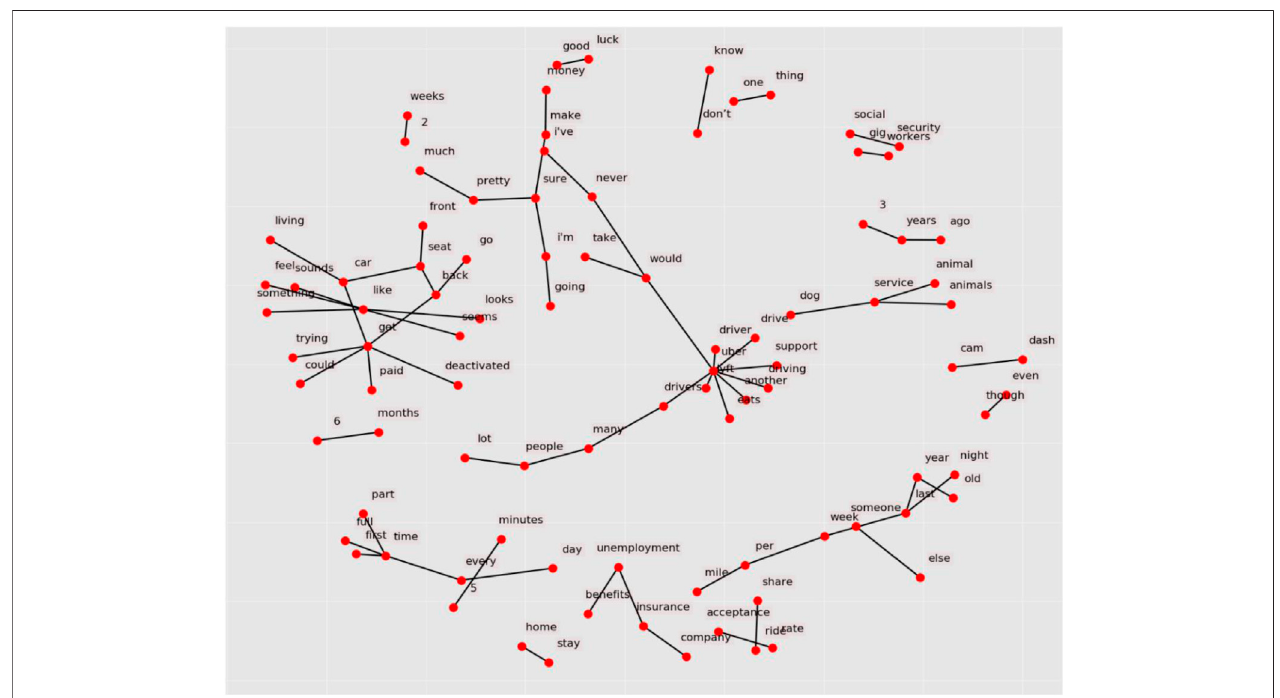
FIGURE 6 | Bigram of Uber Advice forum.